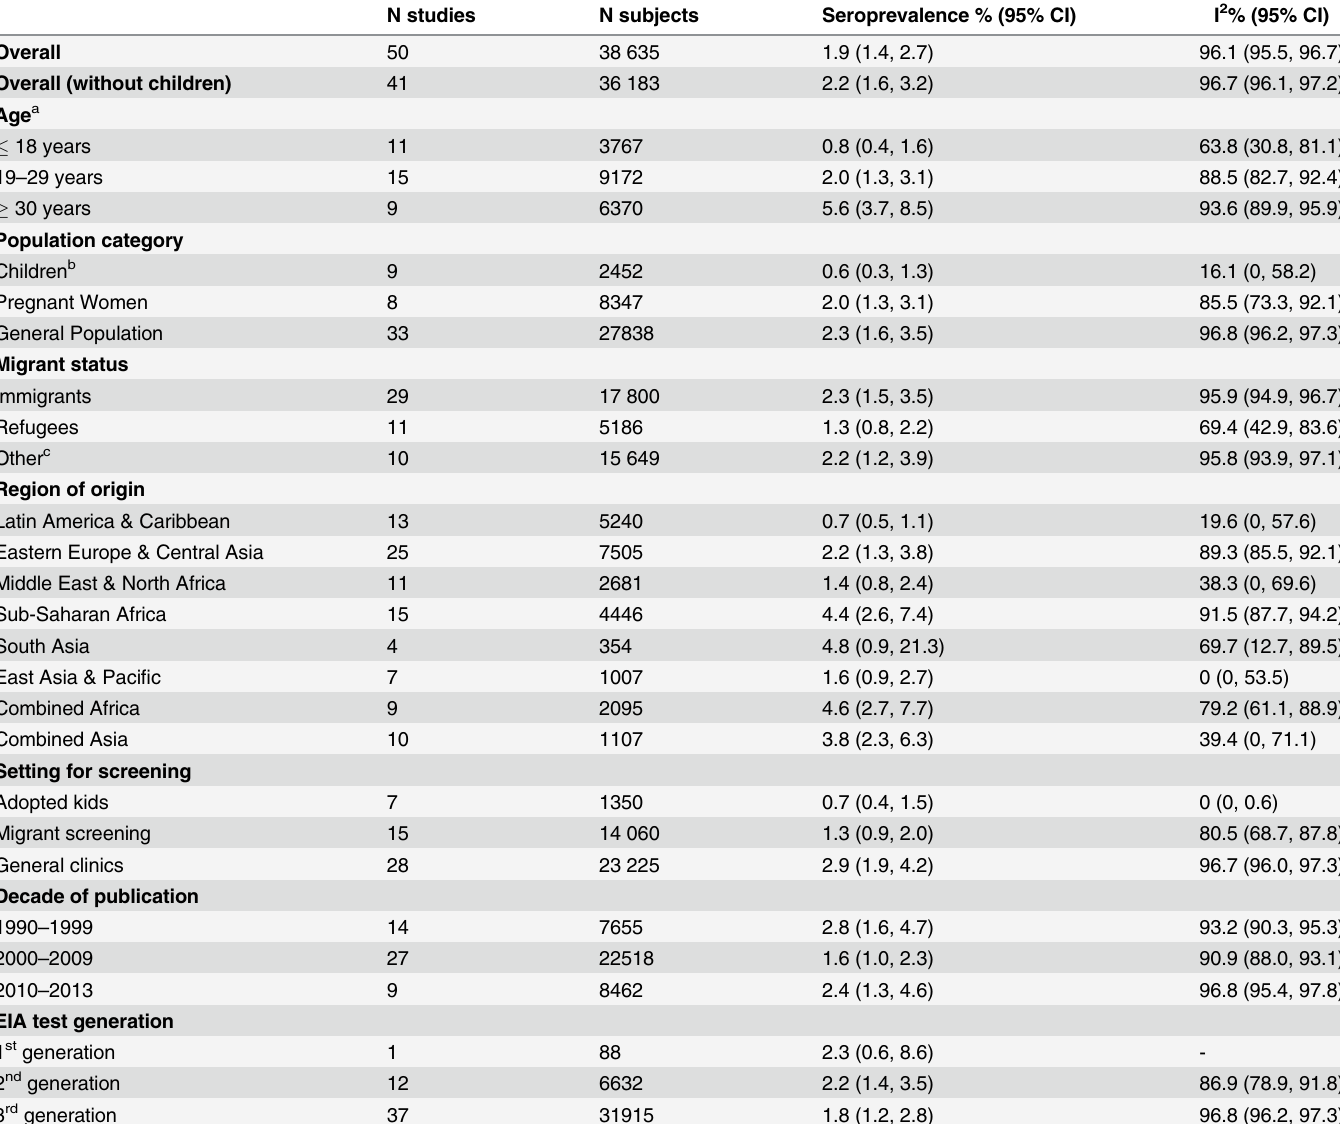
Table 2. Pooled HCV seroprevalence overall and stratified by migration status, region of origin, and age. Abbreviations: CI, confidence